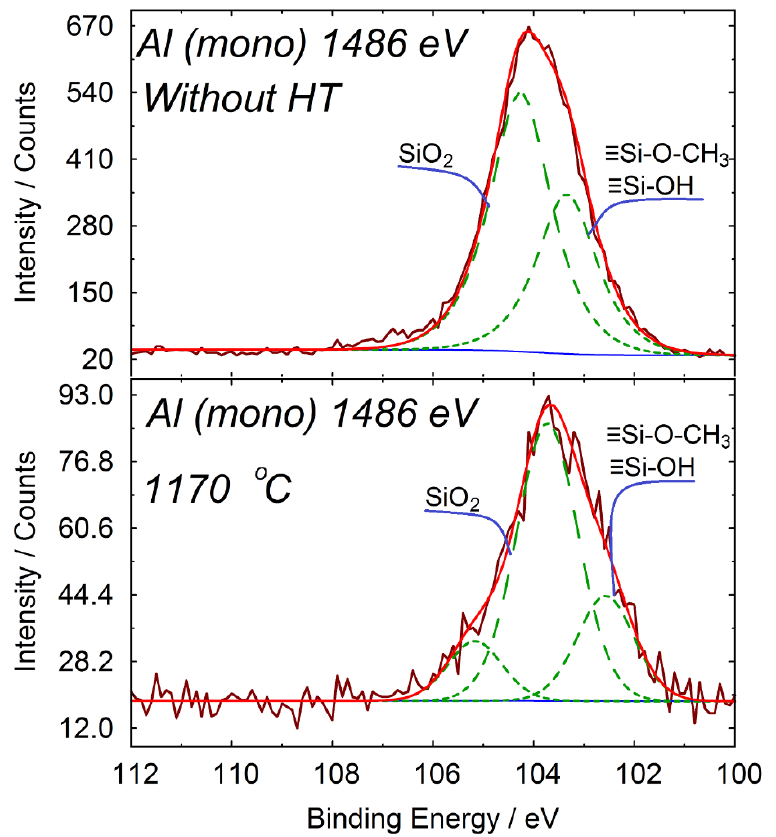
Figure 4. Decomposition of silicon spectrum before heat treatment and after heat treatment at 1170 °C.